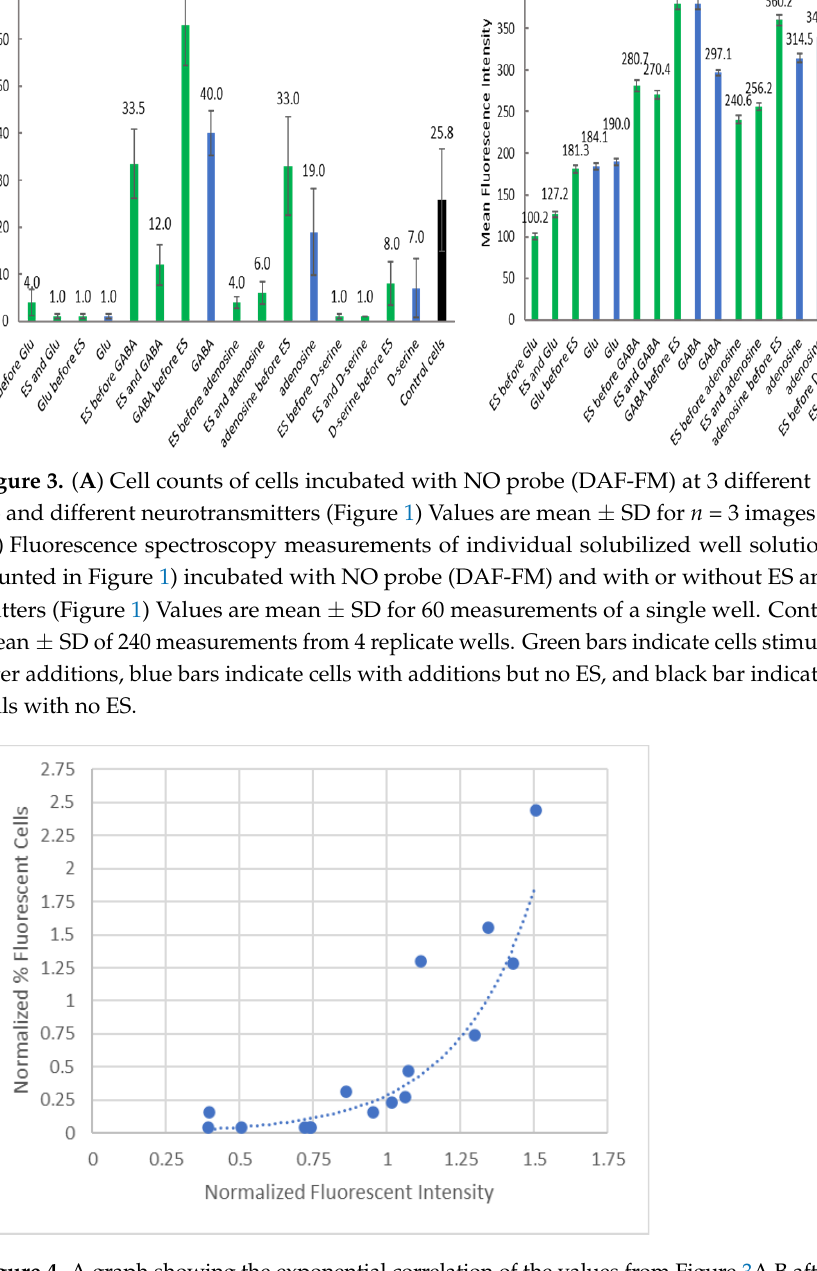
Figure 4. A graph showing the exponential correlation of the values from Figures 3A and 3B after normalizing to the control values showing a strong correlation of the determinations (R 2 = 0.852, y = 0.007e 3.72x